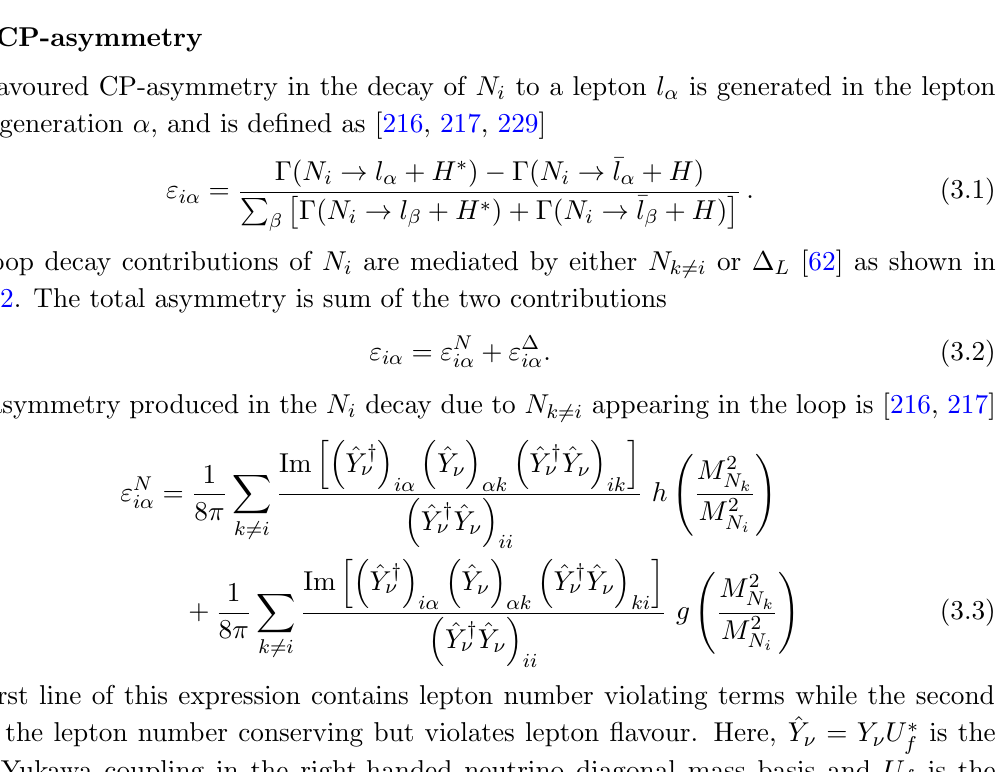
Figure 2 . One-loop Feynman diagrams for the decay of RH neutrino N i . The (cid:12)rst and the third diagrams represent vertex corrections and the second diagram represents self-energy